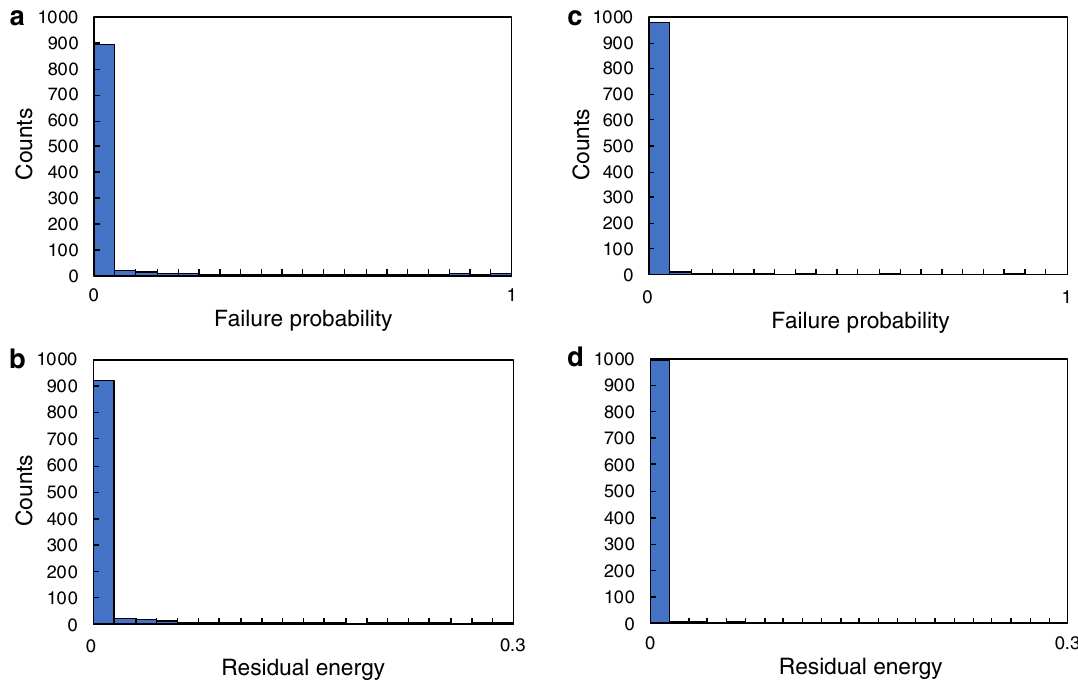
Fig. 1 Comparison between simulations of ground-state quantum annealing and our proposed approach based on excited-state quantum annealing. Here 1000 random instances of the four-spin Ising problem are solved. The coupling coef fi cients J i , j between the i th and j th spins and the local fi eld h i on the i th spin are randomly chosen from the interval ( − 1, 1) with uniform distribution, and normalized by the maximum value of their magnitudes. For all 1000 random instances solved by each method, we measure the failure probability, that is, the probability that we fail to obtain the optimal solution (ground state) of the Ising problem, and the residual energy, i.e., the difference between the ground-state energy of the Ising problem and the expectation value of the Ising energy obtained by quantum annealing (QA). a and b show the results obtained by the ground-state QA with a network of Kerr-nonlinear parametric oscillators (KPOs). c and d show the results obtained by the proposed approach based on the excited-state QA with a KPO